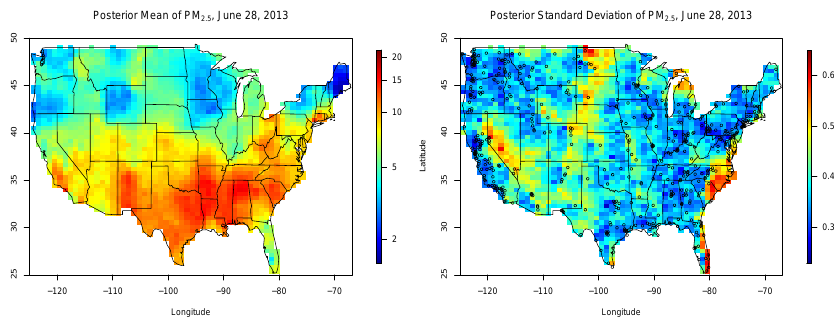
Figure 14. Mean and standard deviation estimates of the posterior predictive distribution of PM 2 . 5 for 28 June 2013. The units of the mean are given in µgm − 3 whereas the standard deviation units are on the log-scale. The dots on the standard deviation map are the locations of the monitoring stations for the observed data used in fitting the model.